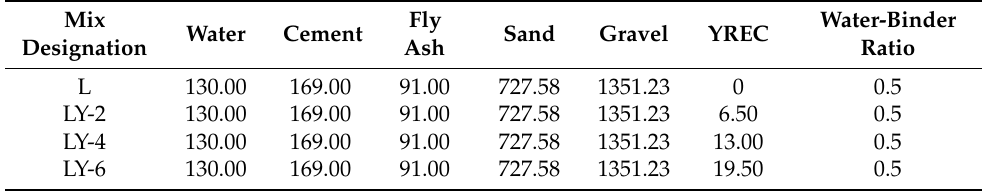
Table 1. Mix proportions of concrete mixes (kg/m 3